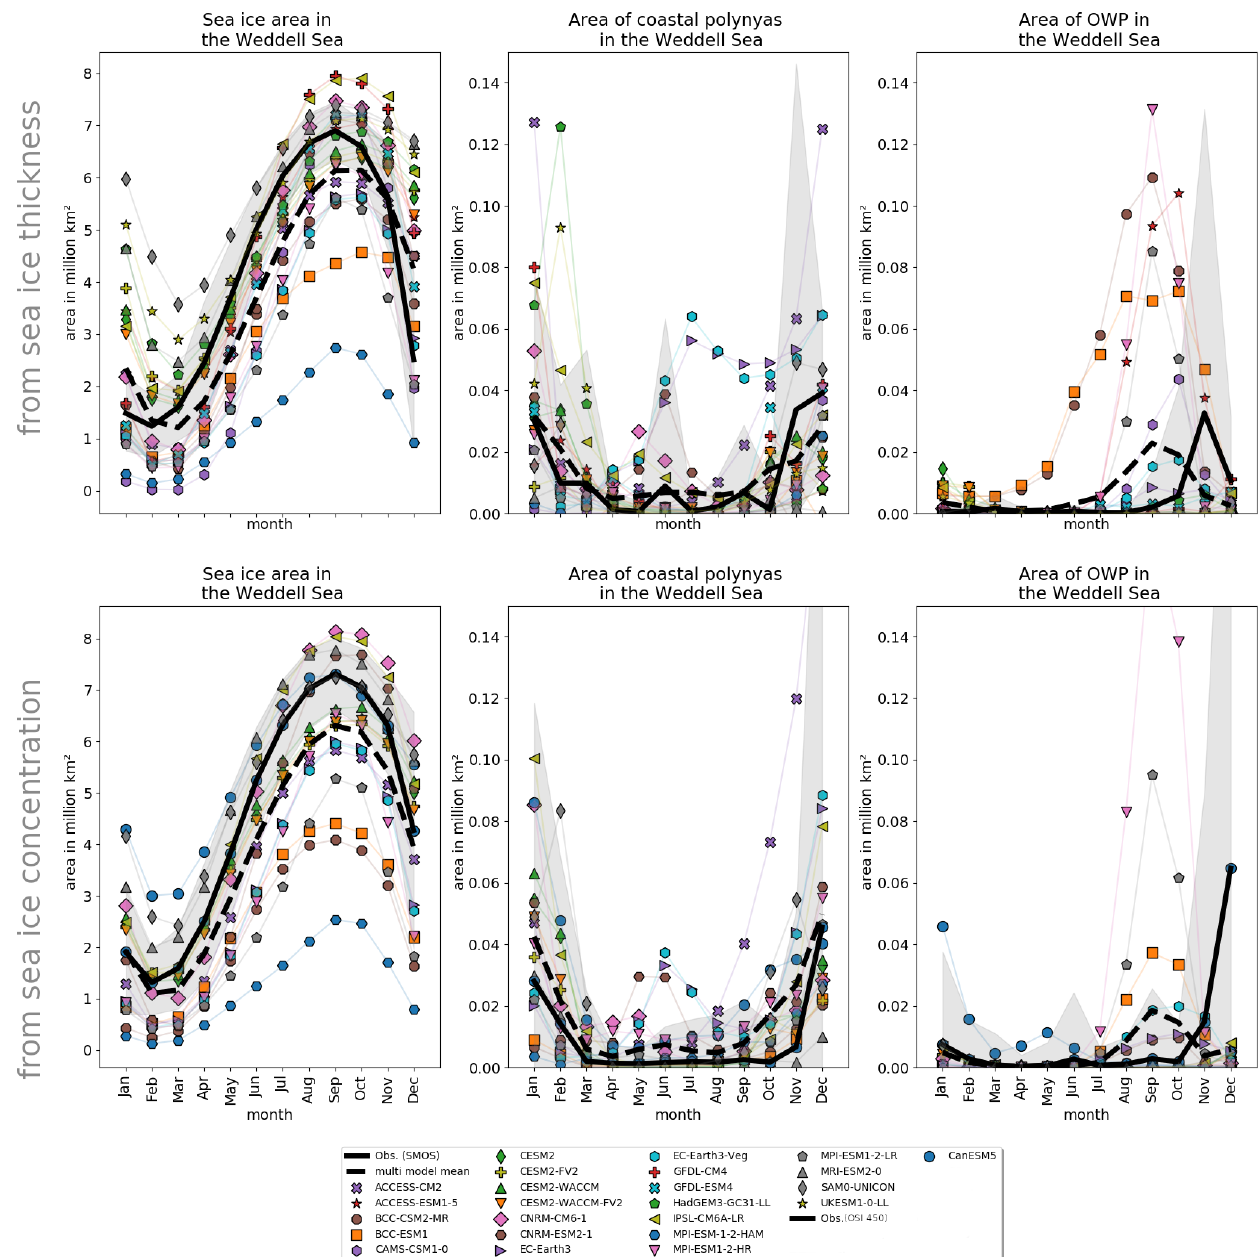
Figure 9. Seasonality of (a, d) the sea ice area; (b, e) the coastal polynyas area; and (c, f) the OWP area, for each CMIP6 model (symbols) and the observation products (plain black lines) in the Weddell Sea sector (65 ◦ W–30 ◦ E). The areas are derived from CMIP6 sea ice thickness and observational SMOS data (a, b, c) and from CMIP6 sea ice concentrations and observational OSI450 data (d, e, f) . Grey shading indicates a 2 standard deviation range from the satellite sea ice data. The data were averaged for the time period